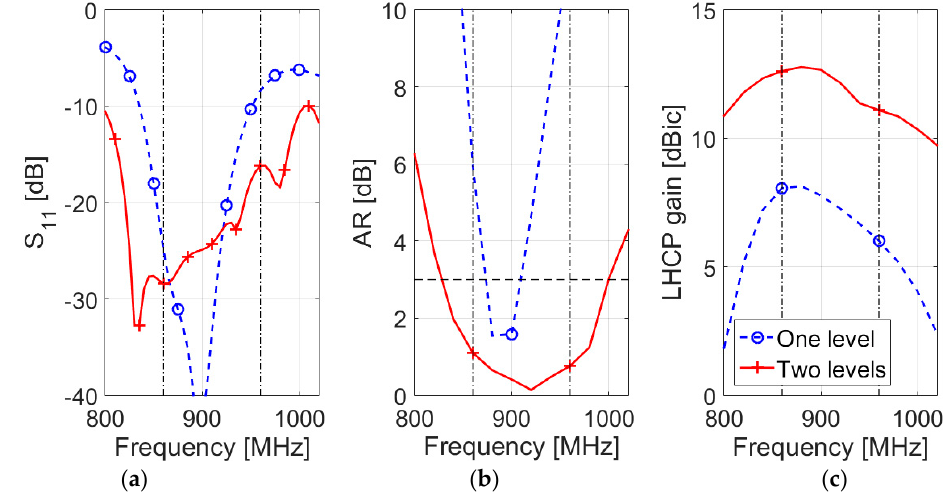
Figure 3. Simulated performance comparison of the antenna array with one and two levels of SR: ( a ) S 11 , ( b ) axial ratio (AR) and, ( c ) left-handed circular polarization (LHCP) broadside gain.